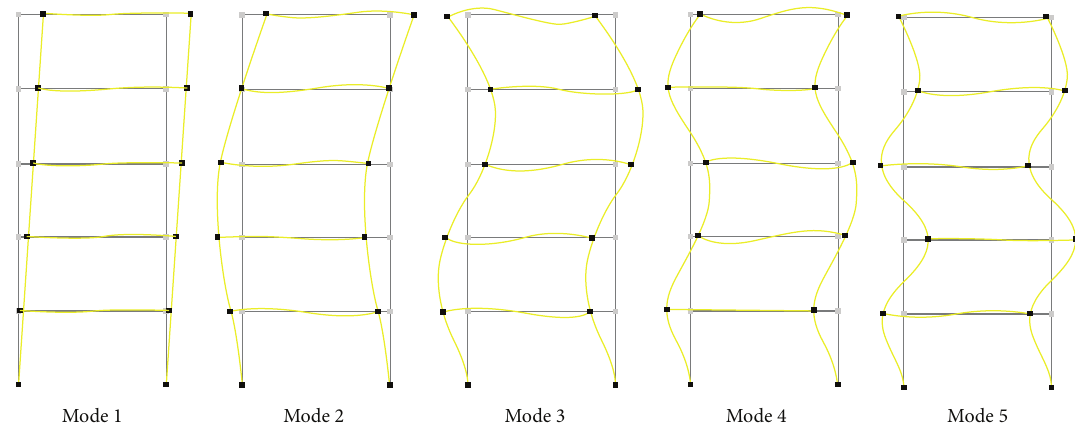
Figure 2: Mode shapes of the five translational